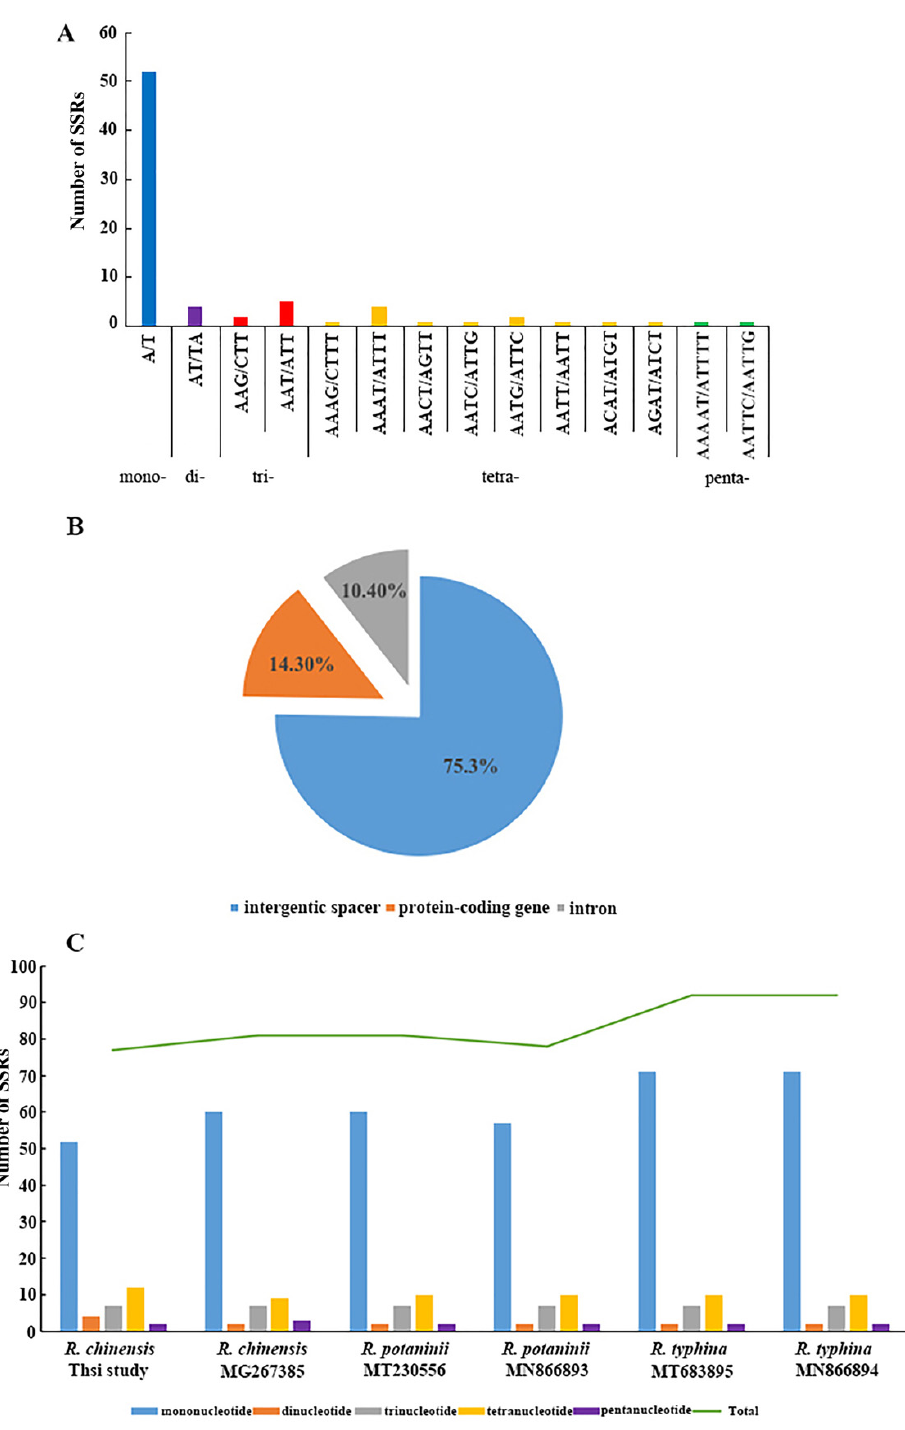
Figure 3. SSRs in the chloroplast genome of Rhus species. ( A ) Frequency of identified SSR motifs in R. chinensis . Mono-: Mononucleotide, Di-: Dinucleotide, Tri-: Trinucleotide, Tetra-: Tetranucleotide, Penta-: Pentanucleotide, Hexa-: Hexanucleotide. ( B ) Location distribution of all the SSR motifs in R. chinensis . ( C ) Number of different SSR types detected in complete chloroplast genomes of Rhus .